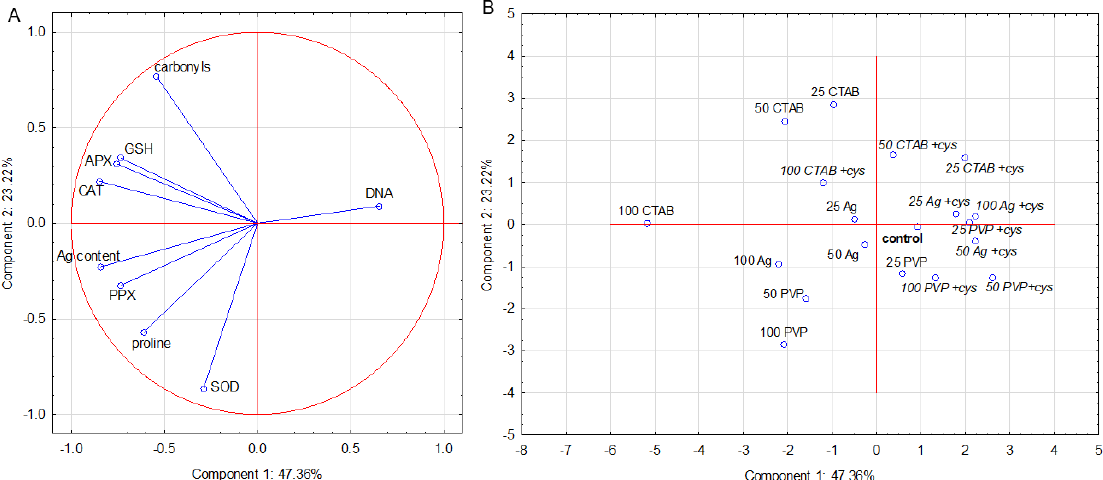
Figure 4. Principal component analysis of leaf data set obtained for tobacco plants 7 days after exposure to 25, 50, and 100 µ M AgNP–PVP, AgNP–CTAB, and AgNO 3 , applied either alone or in combination with cysteine (+cys). ( A ) loadings and ( B ) scores of the first two components (PCs). Silver (Ag) content, reactive oxygen species content (ROS), malondyaldehide content (MDA), glutathione content (GSH), DNA damage (DNA), activity of superoxide dismutase (SOD), ascorbate peroxidase (APX), pyrogallol peroxidase (PPX), and catalase (CAT) represent variables that contributed the most to the combined